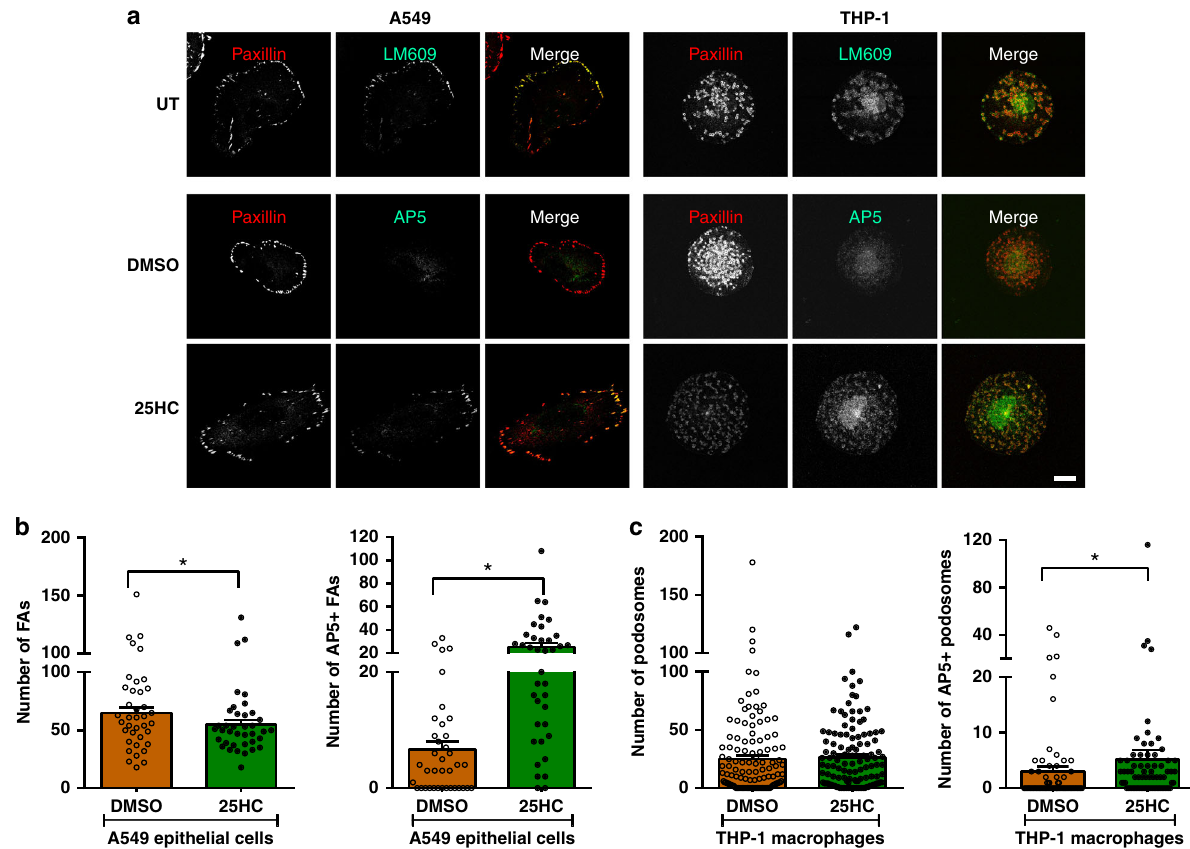
Fig. 4 25HC activates α v β 3 integrin in epithelial cell focal adhesions and macrophage podosomes. a Human lung epithelial cells (A549 cells) or differentiated THP-1 macrophages were subjected to various treatments and immunostained as indicated. In untreated (UT) A549 and THP-1 cells ( fi rst row), α v β 3 integrin, immunostained using the antibody LM609, was present in paxillin-positive focal adhesions and podosomes, respectively. In contrast, active α v β 3 integrin staining, indicated using the antibody AP5 (second and third row), was found almost exclusively in cells treated for 2 h with 0.5 µ M 25HC compared with DMSO-treated controls. Merged images show the co-localization of α v β 3 integrin (total or activated) with focal adhesions/ podosomes. Bar, 10 µ m. b Quanti fi cation of the number of focal adhesions (FAs) and AP5 + FAs in A549 cells (three experiments, >12 cells per experiment; n ≥ 30). c Quanti fi cation of the number of podosomes and AP5 + podosomes in THP-1 cells (three experiments, 25 cells per experiment; n ≥ 70). Two- and One-tailed Wilcoxon rank-sum tests were performed to evaluate differences between total and AP5 + FA/podosome counts, respectively. Graphs depict mean ± SEM. * p ≤